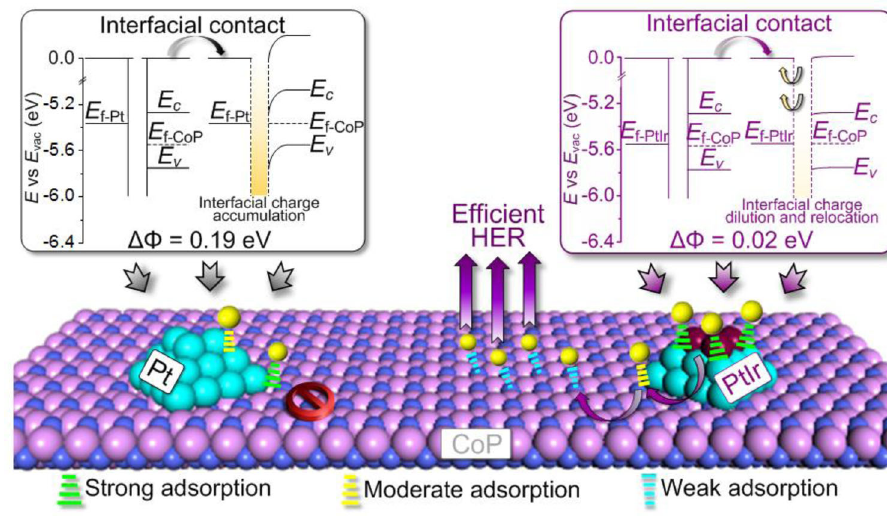
Fig. 8 Mechanic Insights. Proposed nature of the Δ Φ on the hydrogen spillover phenomenon in HSBB